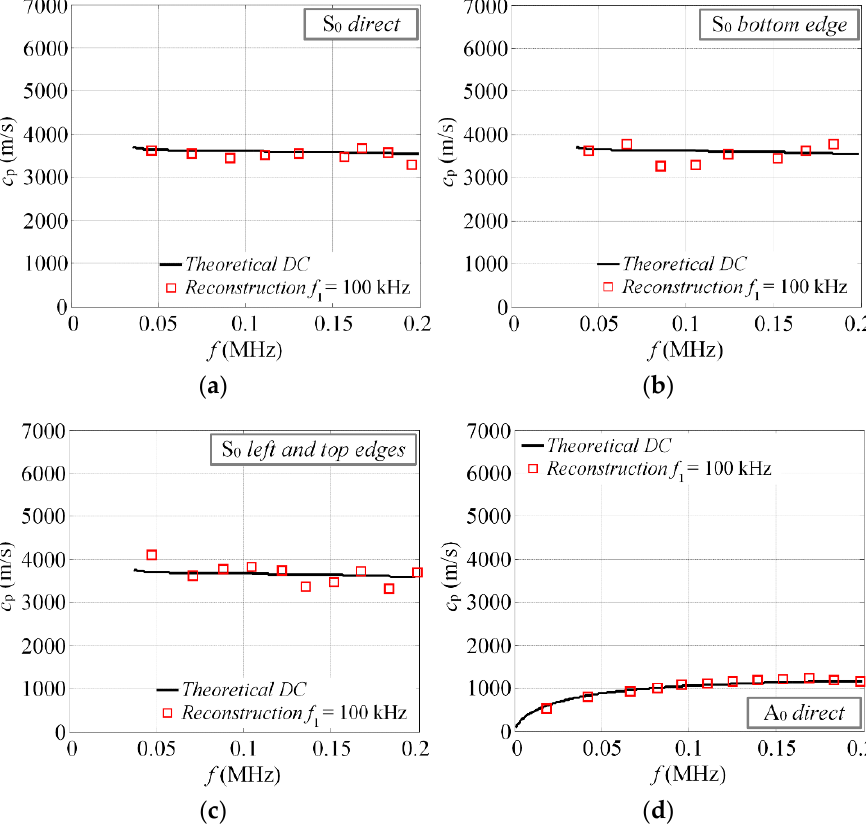
Figure 12. The reconstructed phase velocities of the S 0 and A 0 modes: ( a ) S 0 direct; ( b ) S 0 bottom edge reflected; ( c ) S 0 left and top edge reflected; ( d ) A 0 direct. Table 1. The standard deviation of the estimated phase velocities for different GW mode packets.